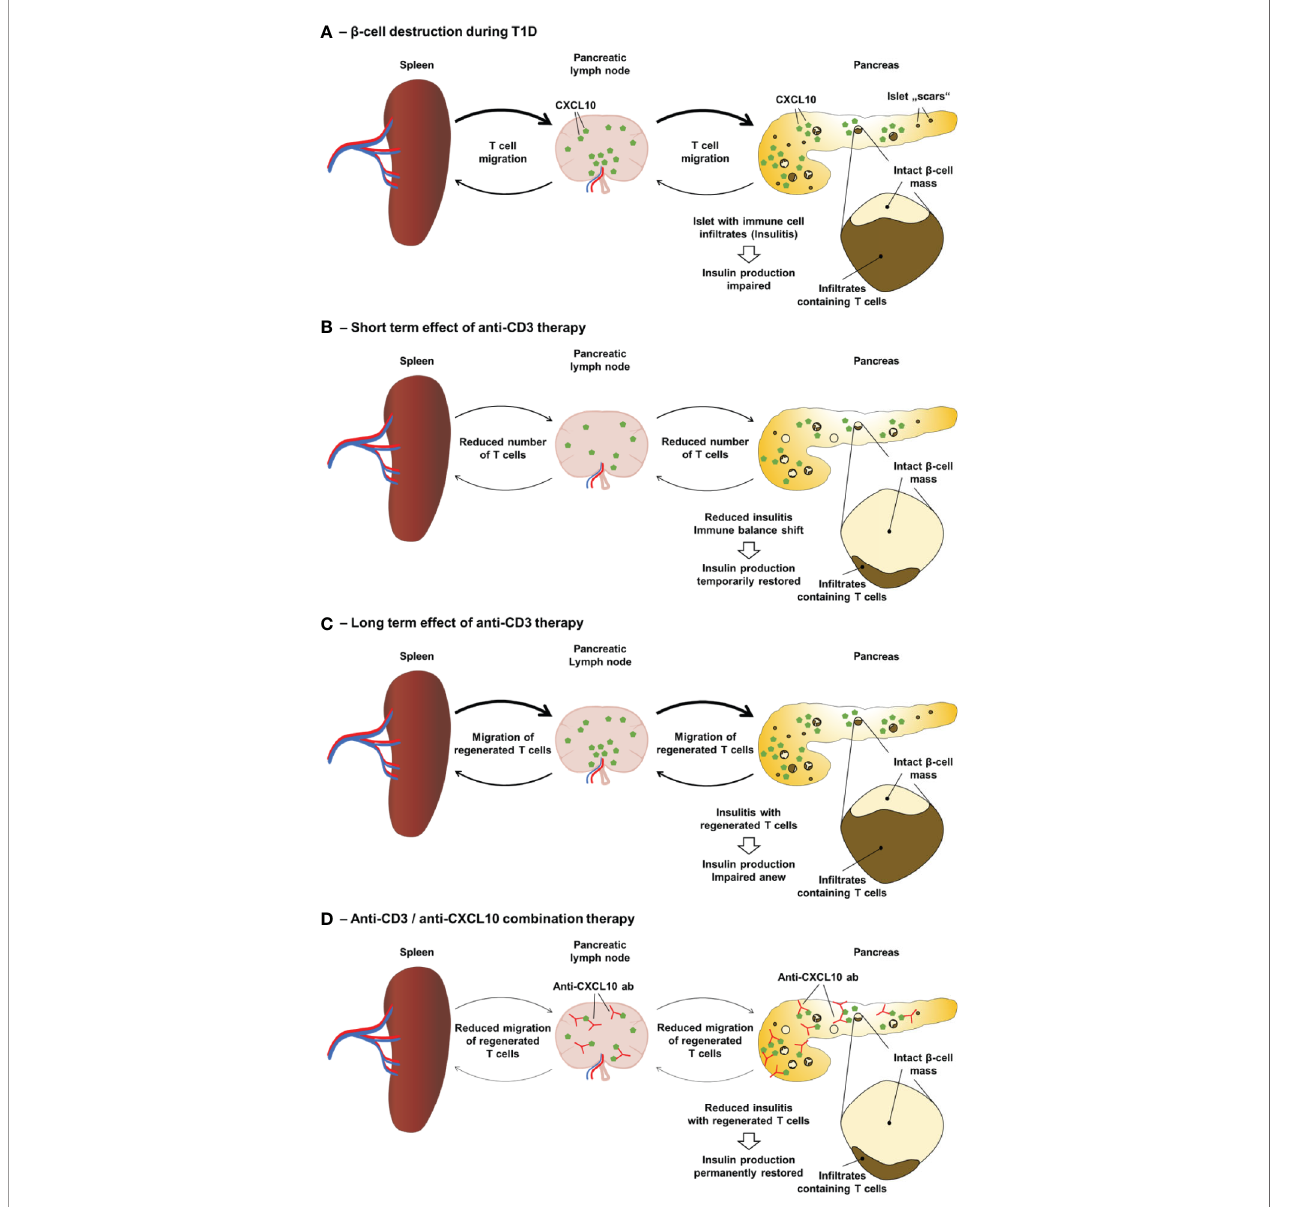
FIGURE 1 | Anti-CD3/anti-CXCL10 combination therapy for type 1 diabetes. (A) Local expression of CXCL10 and other chemokines in the islets of Langerhans as well as in the pancreatic lymph nodes drive the migration of leukocytes, including autoaggressive T cells to the islets. Due to b -cell destruction and stress the insulin production is insuf fi cient to control the blood glucose level. (B) Anti-CD3 therapy causes a partial depletion of T cells and induces an immune balance shift resulting in a reduced insulitis and a temporarily restored insulin production. (C) However, in T1D patients anti-CD3 therapy only lasts for 1 – 2 years and in diabetic mice only about 30% go into remission. Regenerated T cells migrate to the islets and the self-destructive process start anew resulting in an impaired insulin production. (D) Administration of neutralizing anti-CXCL10 antibodies after the anti-CD3 therapy inhibits the migration of regenerated T cells and thereby prevents the re-in fi ltration of the islets resulting in a permanent T1D